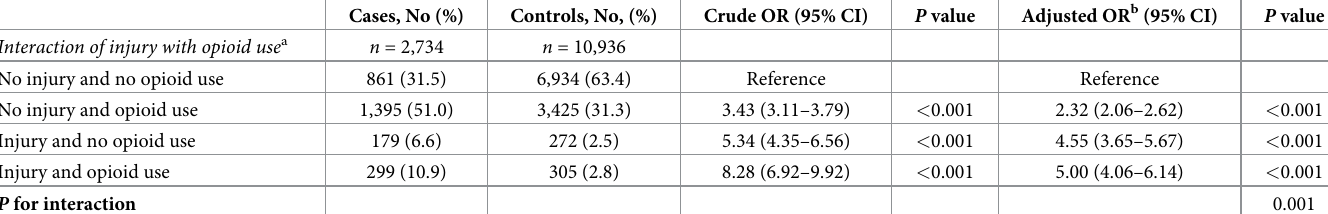
Table 4. Interaction of injury and prescription opioid use within the 30 days before the index date and risk of ORAEs. Cases, No